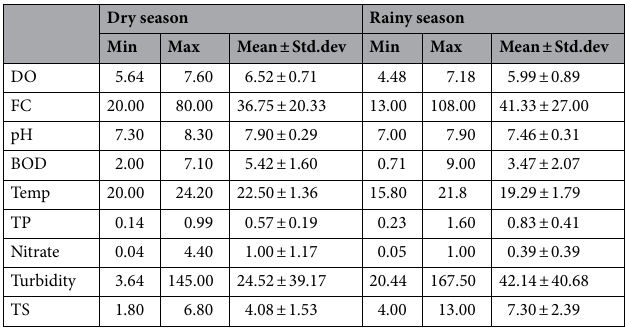
Table 3. Statistical description of Lake Muhazi water quality parameters during the dry and rainy seasons.